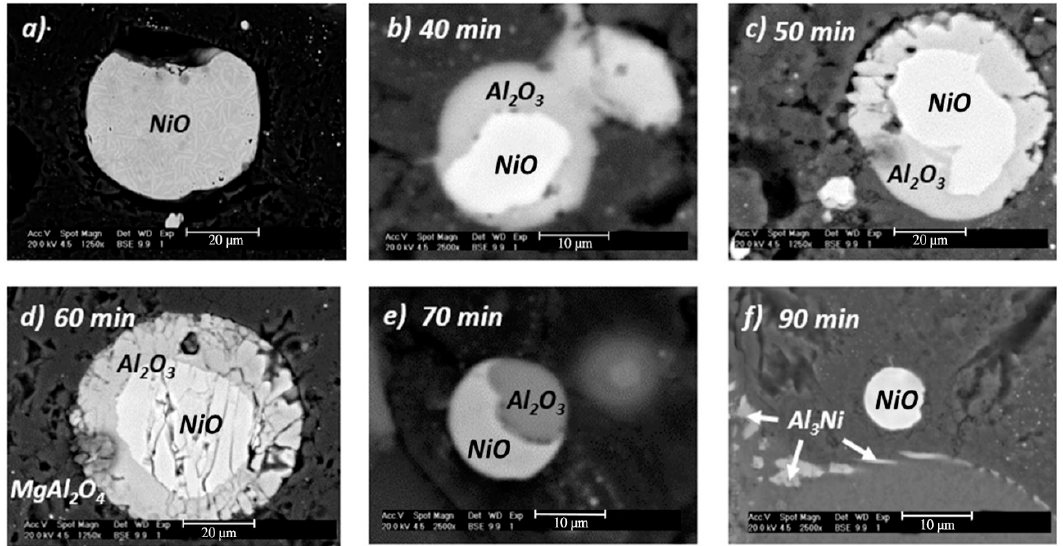
Figure 8. SEM images of partially reacted NiO particles obtained from molten aluminum at 1123 K at a stirring speed of 300 rpm for the indicated times of ( a ) 30 min, ( b ) 40 min, ( c ) 50 min, ( d ) 60 min, ( e ) 70 min, and ( f ) 90 min.